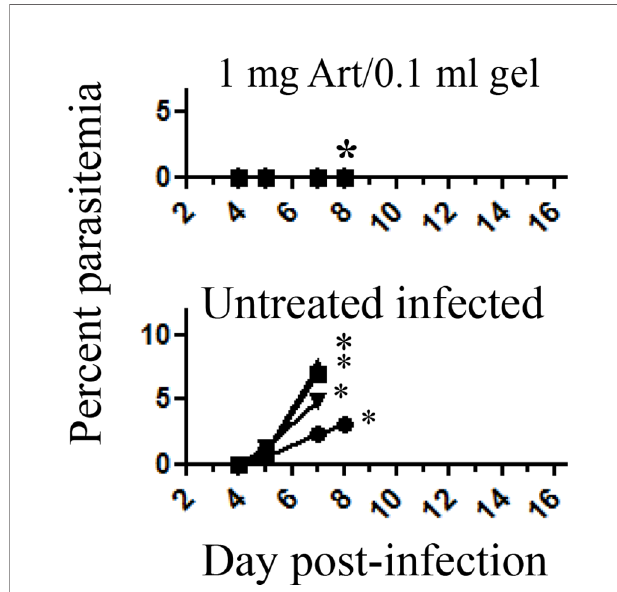
FIGURE 2 | The effect of treatment at 2 days post-infection with PbA. Each curve represents one mouse; Eight days post-infection treated* and untreated* mice that were about to die of CM P = <0.001; were sacri fi ced to estimate liver function; Untreated infected n = 4; Treated n = 6, all treated mice that had not been sacri fi ced survived; Art, artemisone.